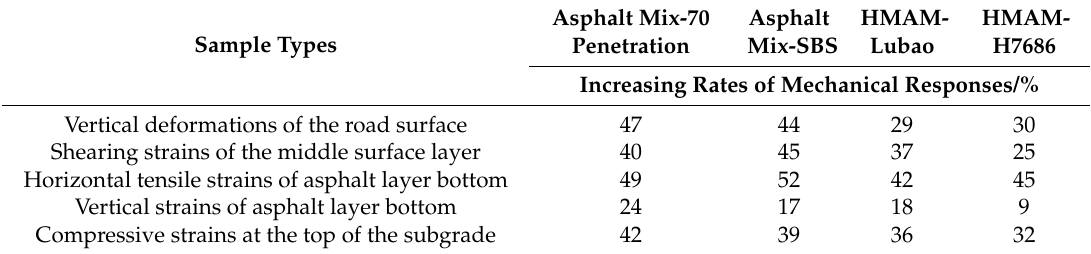
Table 11. Increasing of mechanical responses from standard to heavy